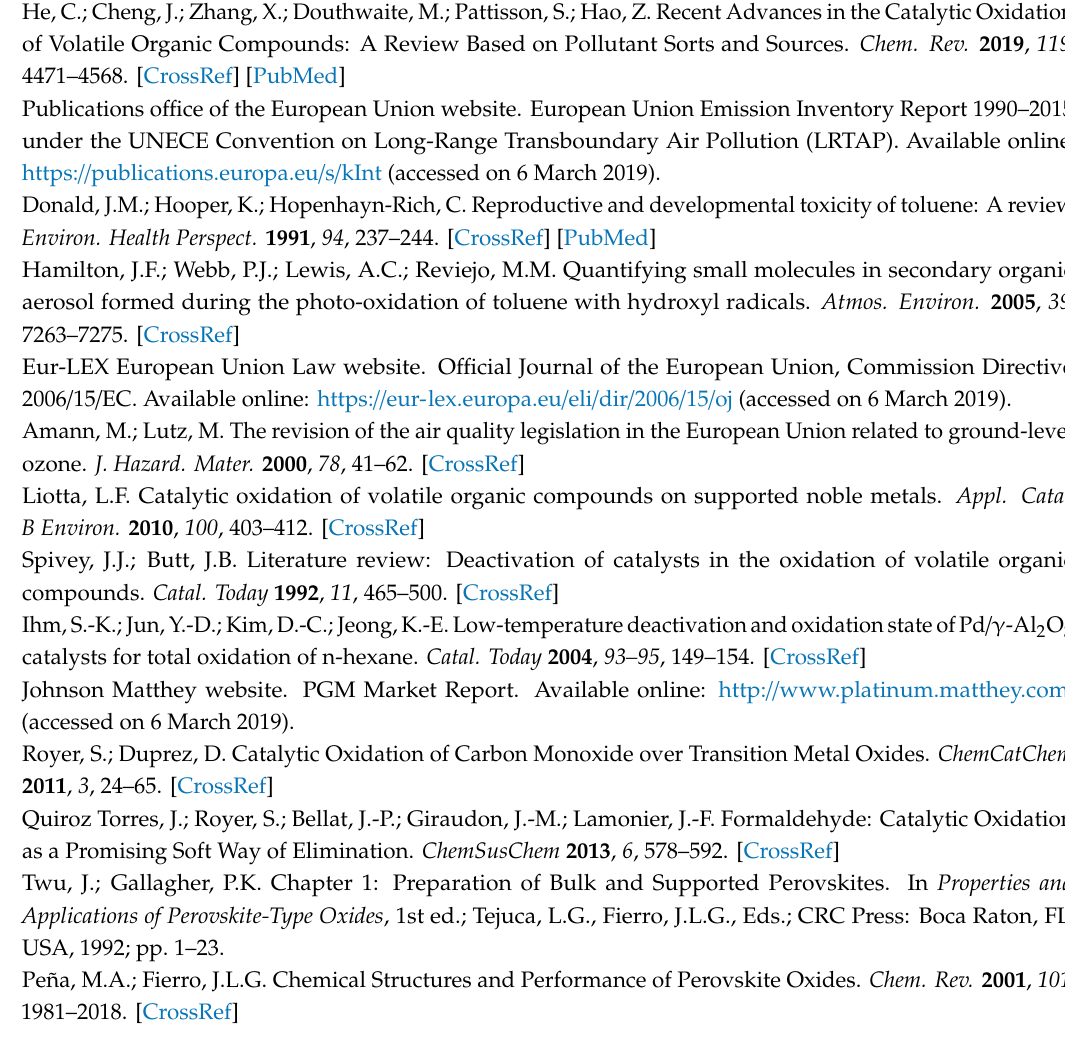
Figure A2. High-resolution spectra of La 3d core level spectra for LaFeO 3 samples: (a) SSR, solid state reaction; (b) HEBM, high-energy ball milling; (c) LEBM, low-energy ball milling.